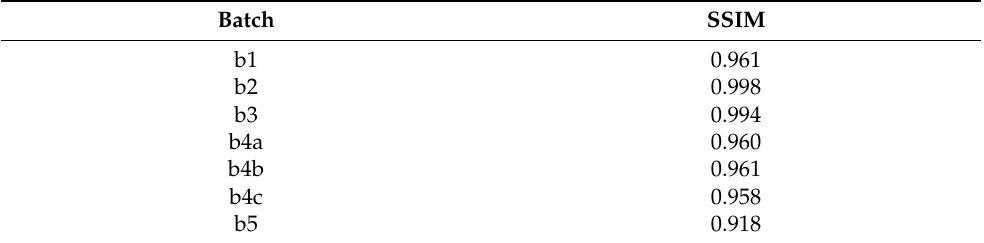
Table 6. Structure similarity index (SSIM) values between the reference heatmap of the CMS peak ratios and the heatmaps of the tested batches (b1, b2, b3, b4a, b4b, b4c and b5), as they were calculated by the “SPUTNIK” package in RStudio. Batch b5 had the lowest